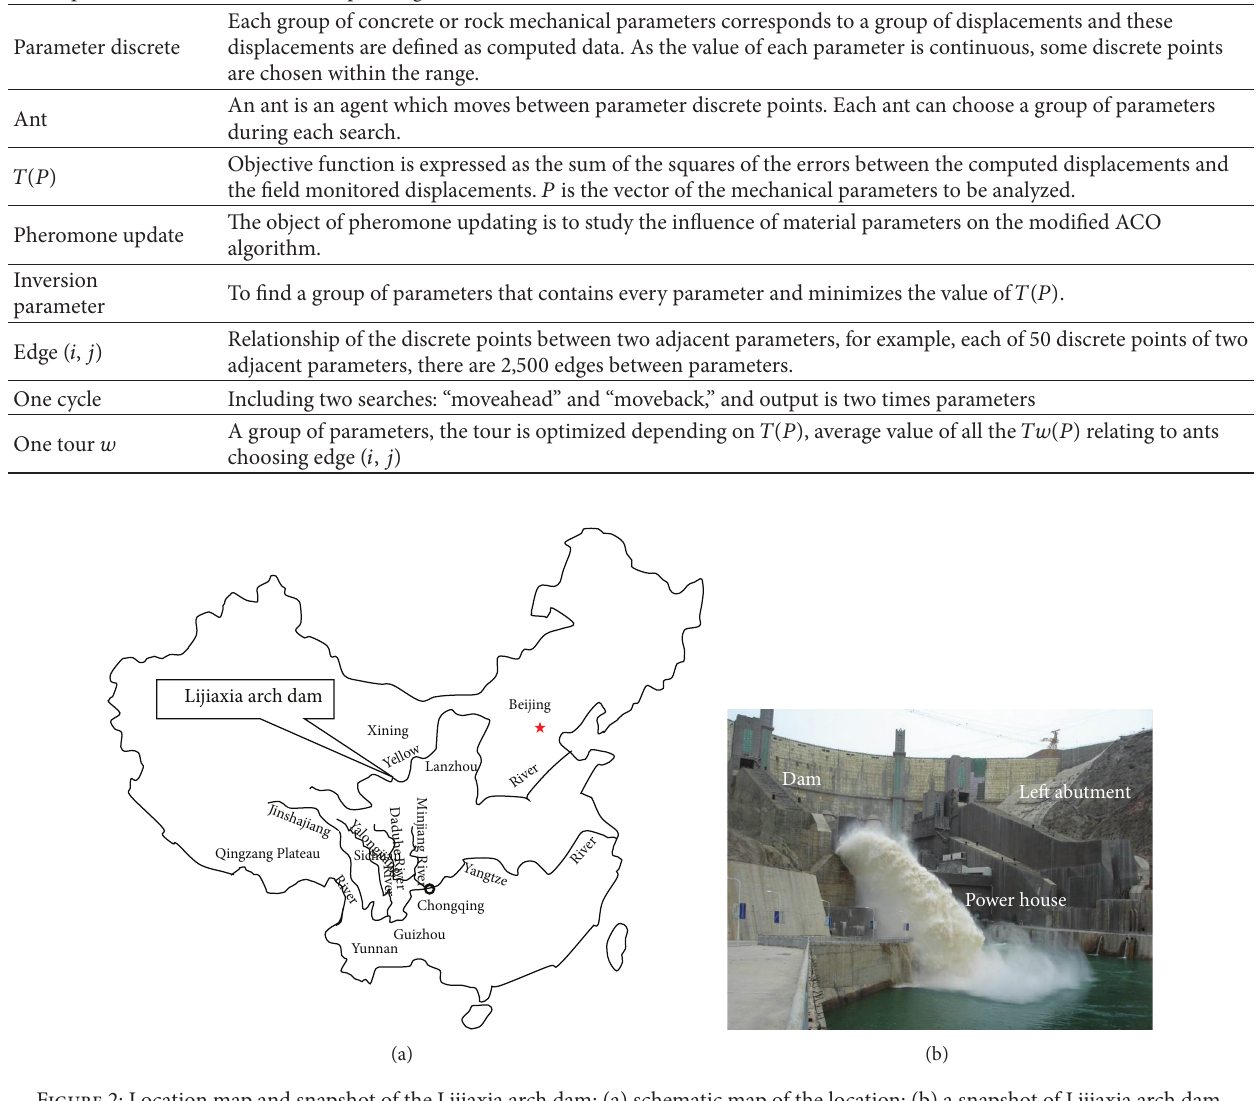
diversion system and a power house structure of units in two rows were constructed at the dam downstream, as shown